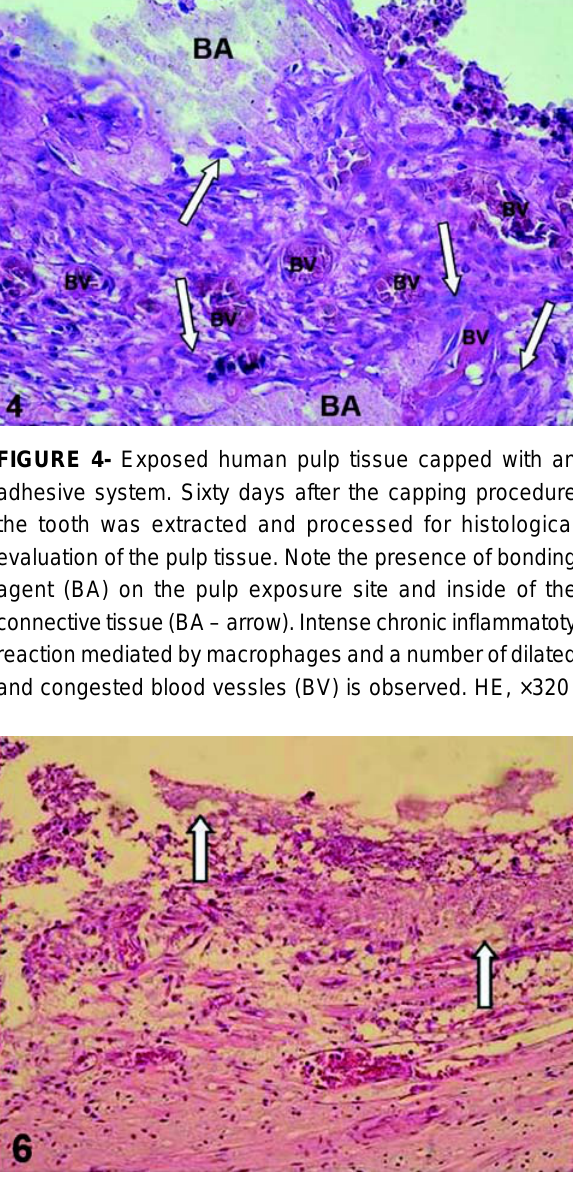
FIGURE 6- Pulp exposure capped with an adhesive system. Note that no hard tissue barrier was formed 60 days after the pulp therapy. Fragments of resinous material (arrows) are observed displaced to the pulp exposure site, which exhibits persistent inflammatory response. HE, ×125